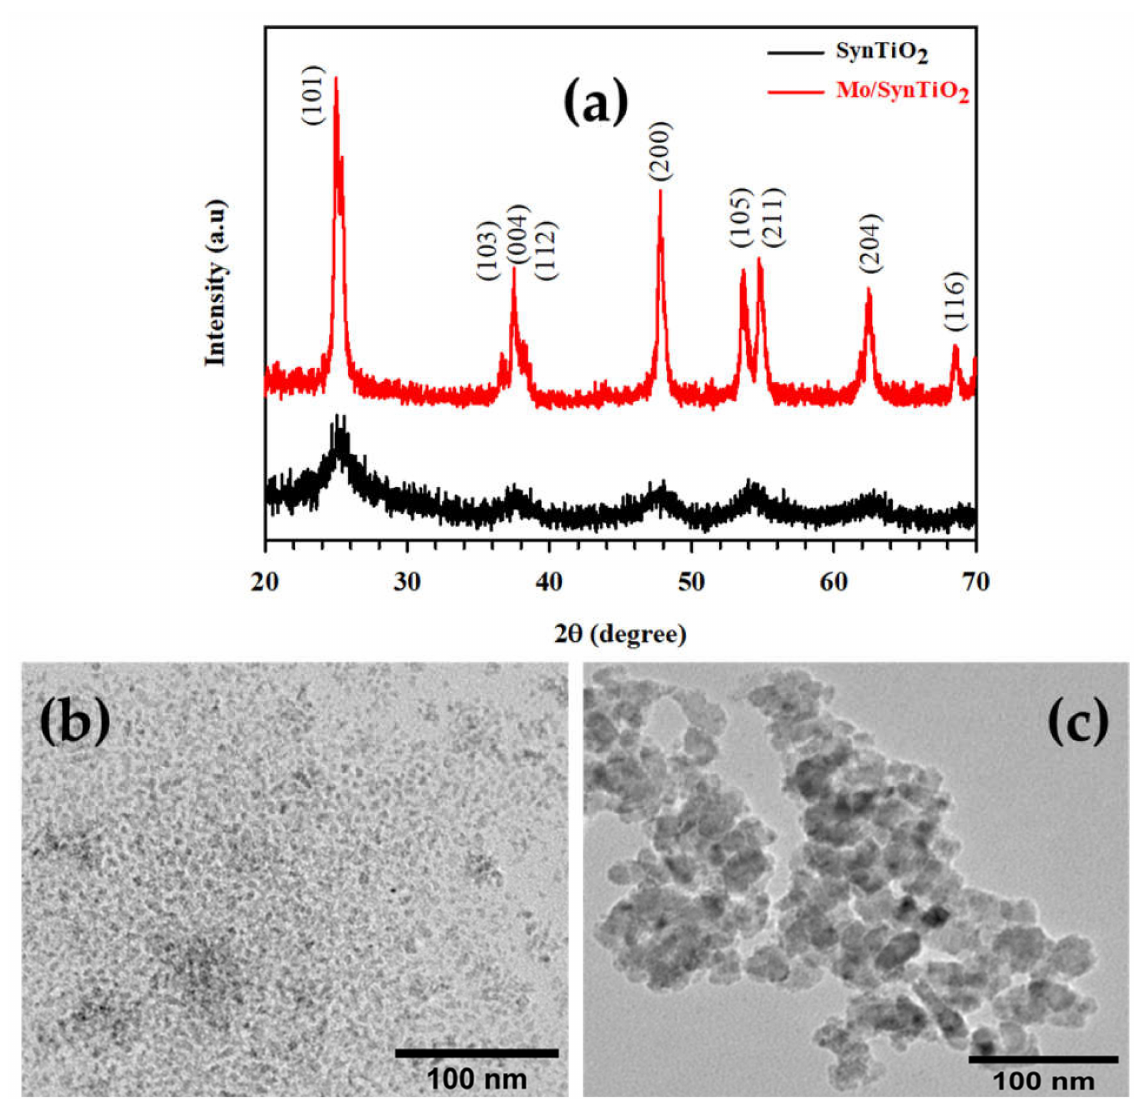
Figure 1. ( a ) XRD measurement for: unmodified SynTiO 2 (black line) and Mo/SynTiO 2 (red line); TEM measurement for ( b ) unmodified SynTiO 2 ; and ( c ) Mo/SynTiO 2 sample